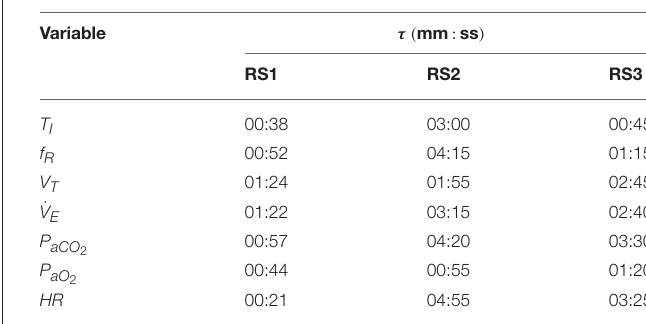
TABLE 1 | Rise time ( τ ) of the dynamic response of RS1, RS2, and RS3 obtained when a step exercise input of ˙ V CO 2 = 1.20 L/min and ˙ V O 2 = 1.50 L/min was used to simulate